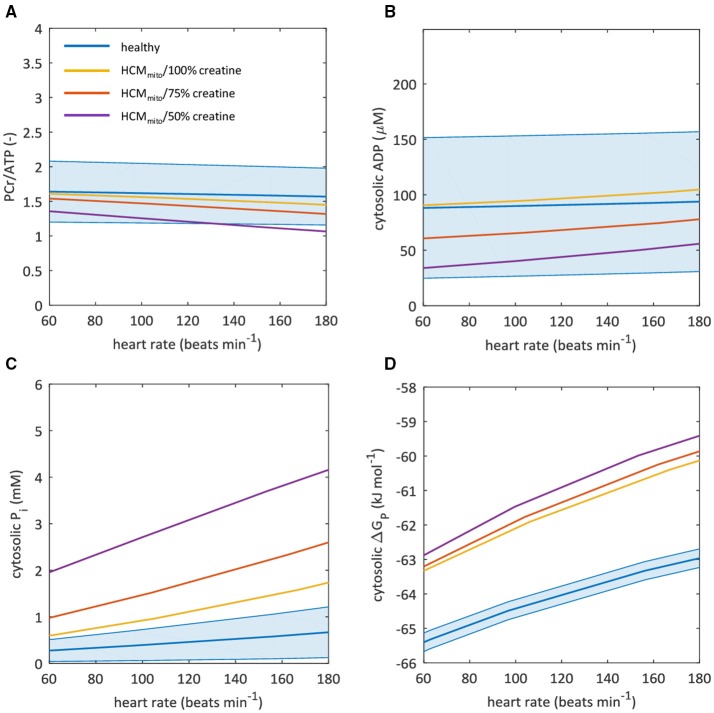
A reduction in mitochondrial capacity to synthesize ATP disturbs myocardial energy homeostasis. Graphs show computational model-based predictions of myocardial energy homeostasis over a range of cardiac work rates for the healthy heart (blue) and for hypertrophic cardiomyopathy due to a 50% reduction in mitochondrial capacity to synthesize ATP (HCMmito) with 100% (yellow), 75% (red), and 50% (purple) of the normal creatine pool size. The solid curve represents the mean of the simulation results while the shaded region reflects the model uncertainty (95% confidence intervals). Resting-state mean and confidence intervals are based on empirical 31P-MRS measurements and associated coefficient of variation for 3D ISIS. (A) myocardial PCr/ATP ratio. (B) cytosolic ADP concentrations. (C) cytosolic Pi concentrations. (D) Gibbs free energy available from ATP hydrolysis ΔGP. ADP, adenosine diphosphate; ATP, adenosine triphosphate; ISIS, image-selected in vivo spectroscopy; PCr, phosphocreatine; Pi, inorganic phosphate.